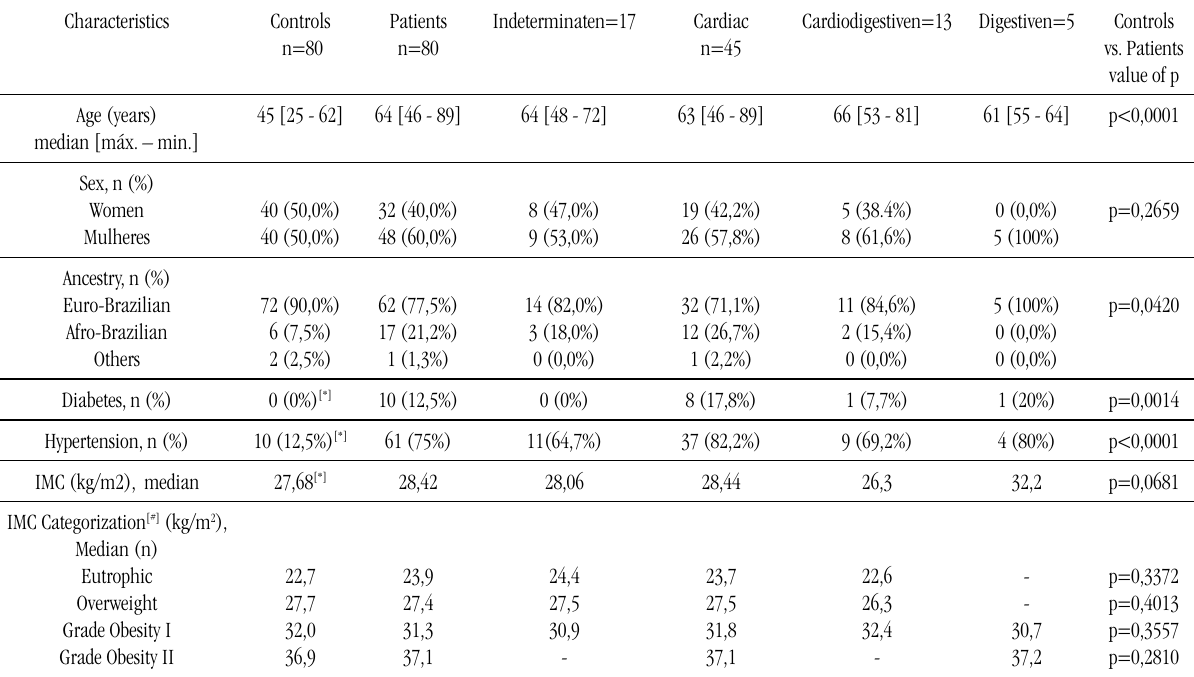
TAbLE 1 – Socio-demographic characteristics and comorbidities in controls and